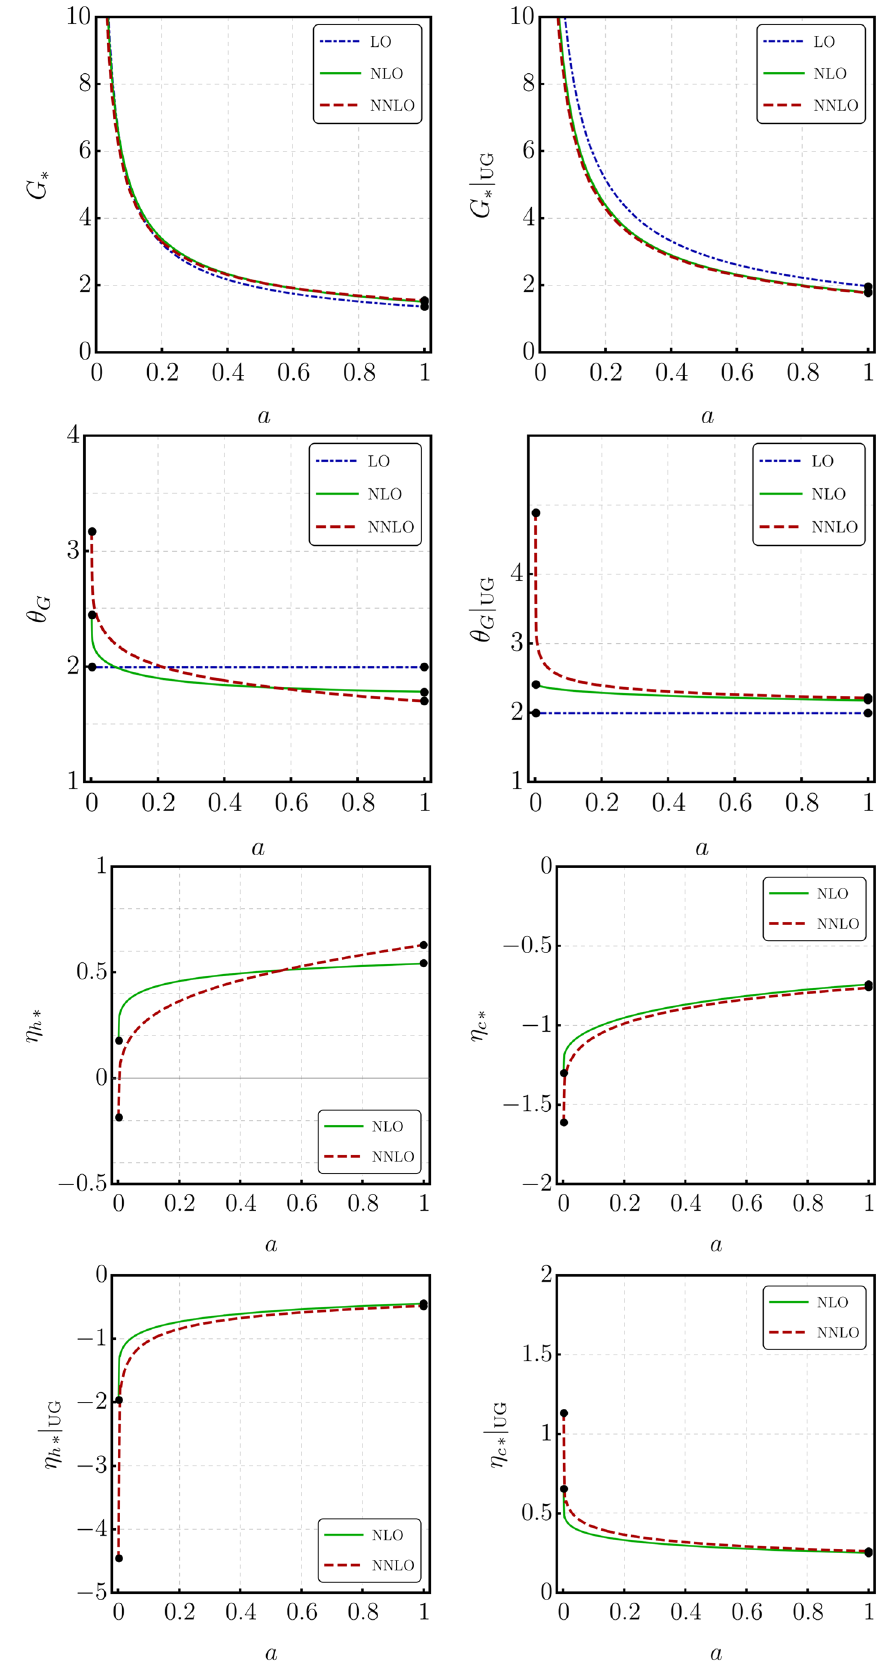
Fig. 8 We show the fixed point G ∗ ( a ) both in standard gravity (left panel) and unimodular gravity (right panel). In both cases we consider different approximations for the